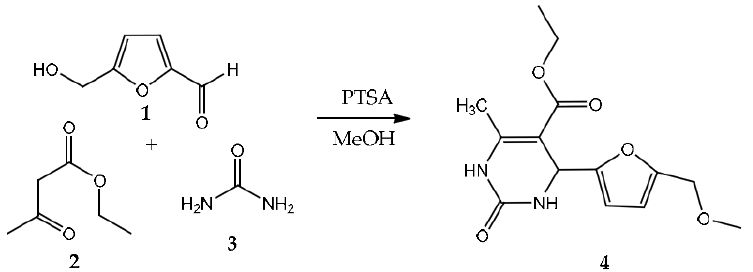
Scheme 1. Synthesis of ethyl 4-[5-(methoxymethyl)furan-2-yl]-6-methyl-2-oxo-1,2,3,4-tetrahydro